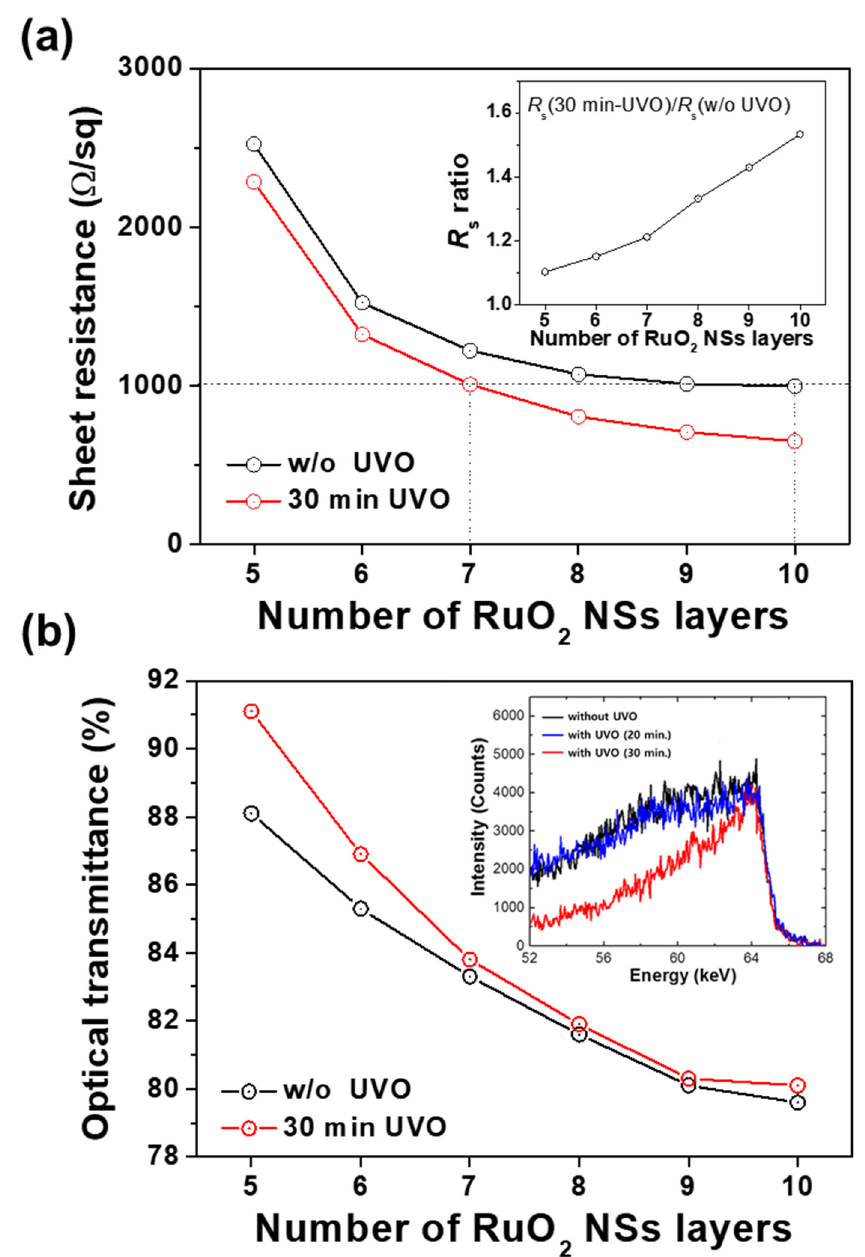
Figure 4. Dependence of ( a ) sheet resistance and ( b ) optical transmittance on the number of NS layers, where the inset of ( a ) exhibits the ratio of sheet resistance. The inset of ( b ) is the Rutherford backscattering spectrometry (RBS) spectrum of the samples with different UVO treatment times (0, 20, and 30 min).